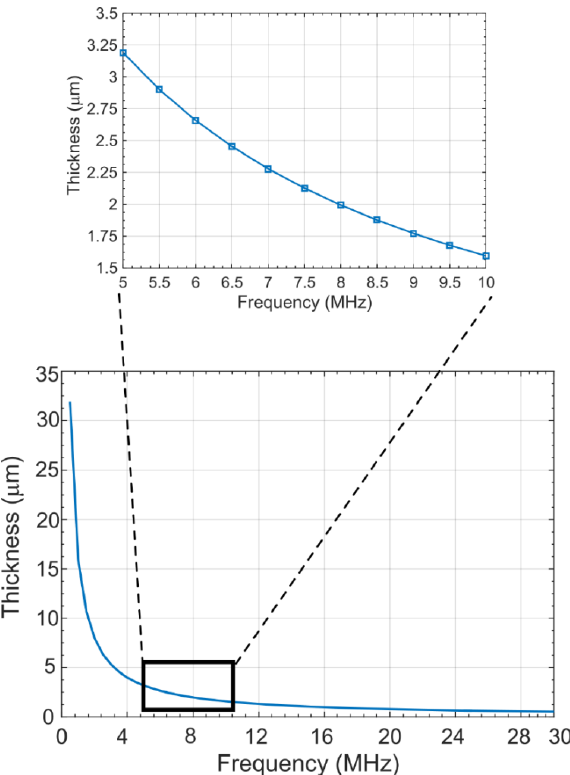
Figure 8. Coating thickness for various center frequency of operation [21].